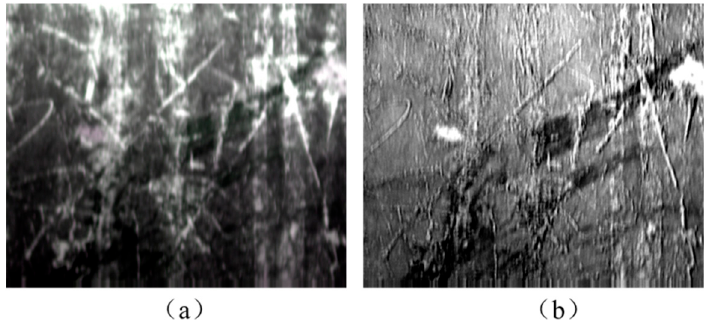
Figure 5. The experimental results of area 1. ( a ) Color image (synthesized from the images after MNF inverse transform); ( b ) NIR image at 790 nm; ( c ) image after image subtraction.